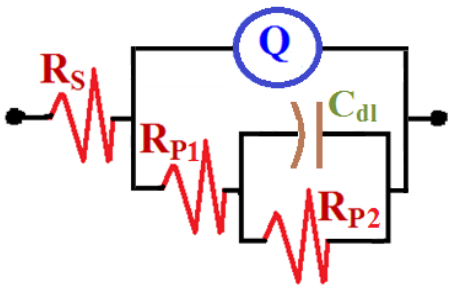
Figure 6. Typical Nyquist plots obtained for the Al–TiC composite sintered at ( 1 ) 900, ( 2 ) 1100, and ( 3 ) 1300 °C after 1 h immersion in 3.5% NaCl solutions.